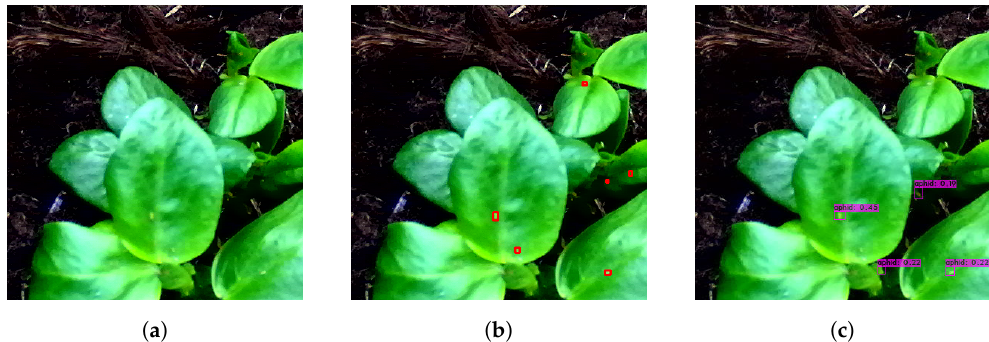
Figure 9. Example of aphid detection with YOLOv4 on a test frame. Readers can observe that the prediction missed 3 aphids and found a false one. ( a ) Original image; ( b ) Ground truth image; ( c ) Predicted